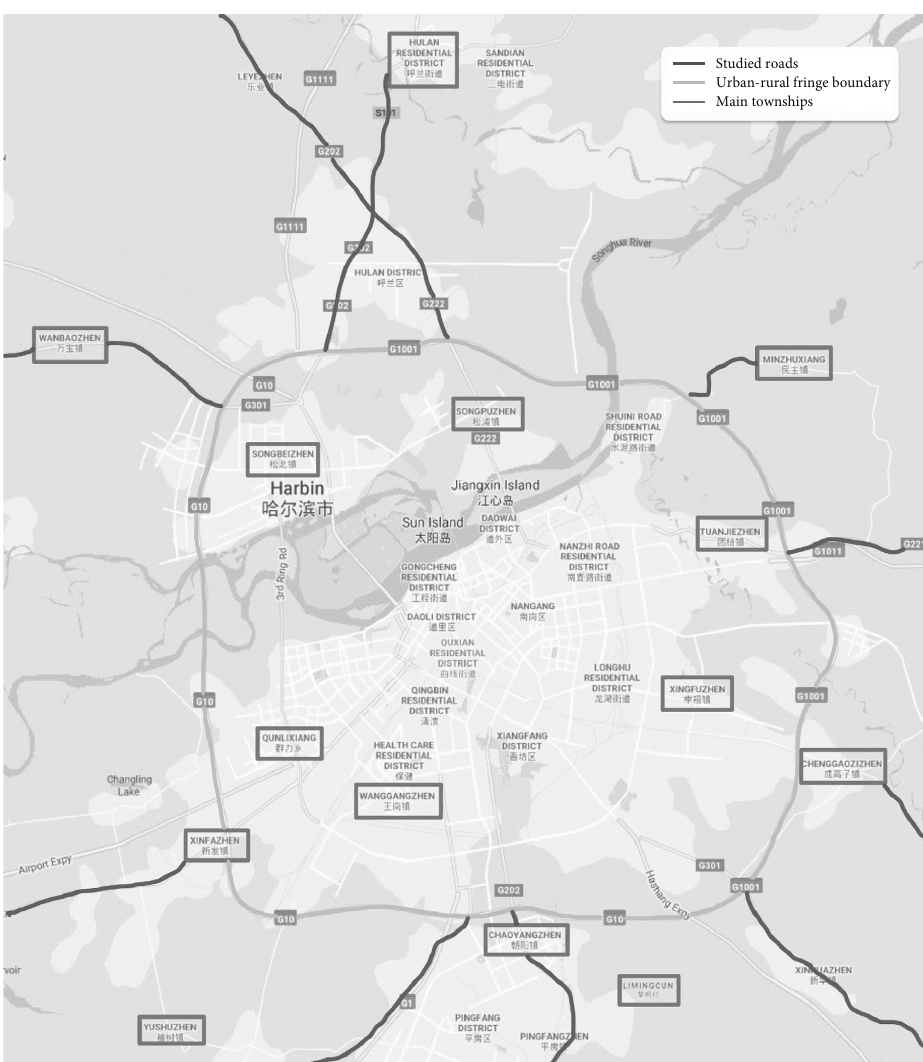
Figure 2: Geographical location and surrounding environment of research